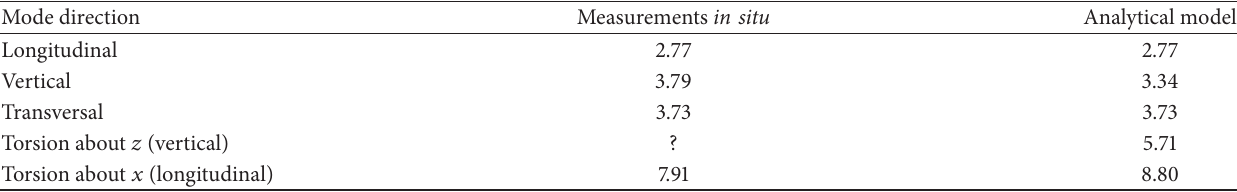
Table 7: Comparison of frequencies (Hz) between measurements in situ and the analytical